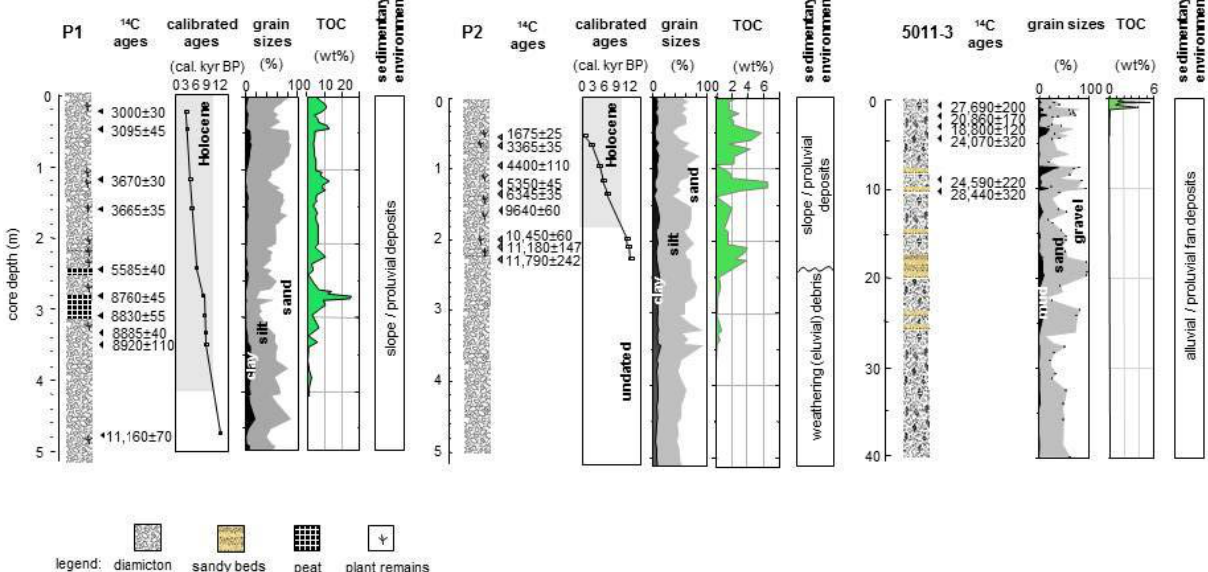
Fig. 2. Lithological, geochronological, grain size and TOC data from P1, P2, and 5011-3 cores.